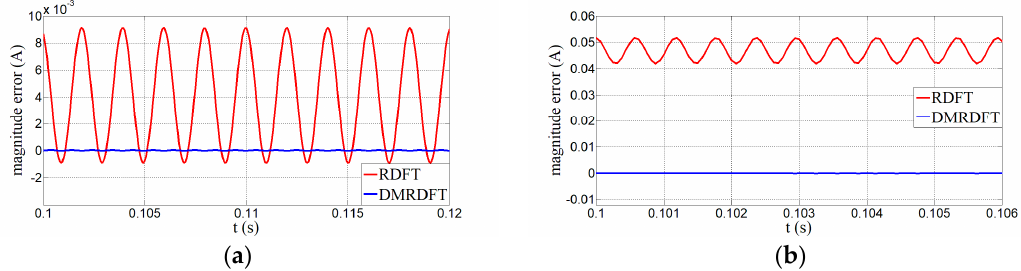
Figure 10. Correction effect on selective harmonic magnitude detection: ( a ) 5th harmonic ( k = 5), and ( b ) 17th harmonic ( k = 17).